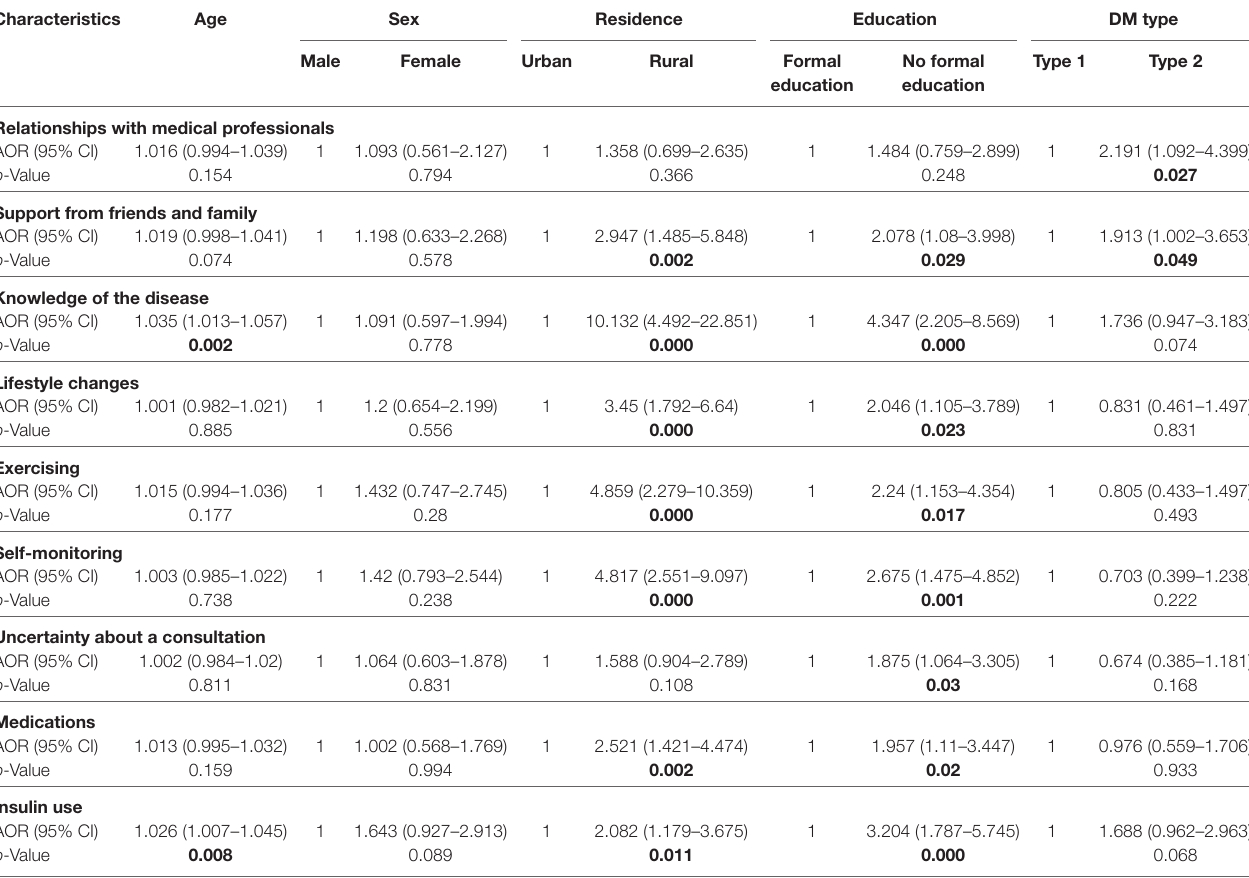
TaBle 4 | Diabetes obstacles and associated factors.